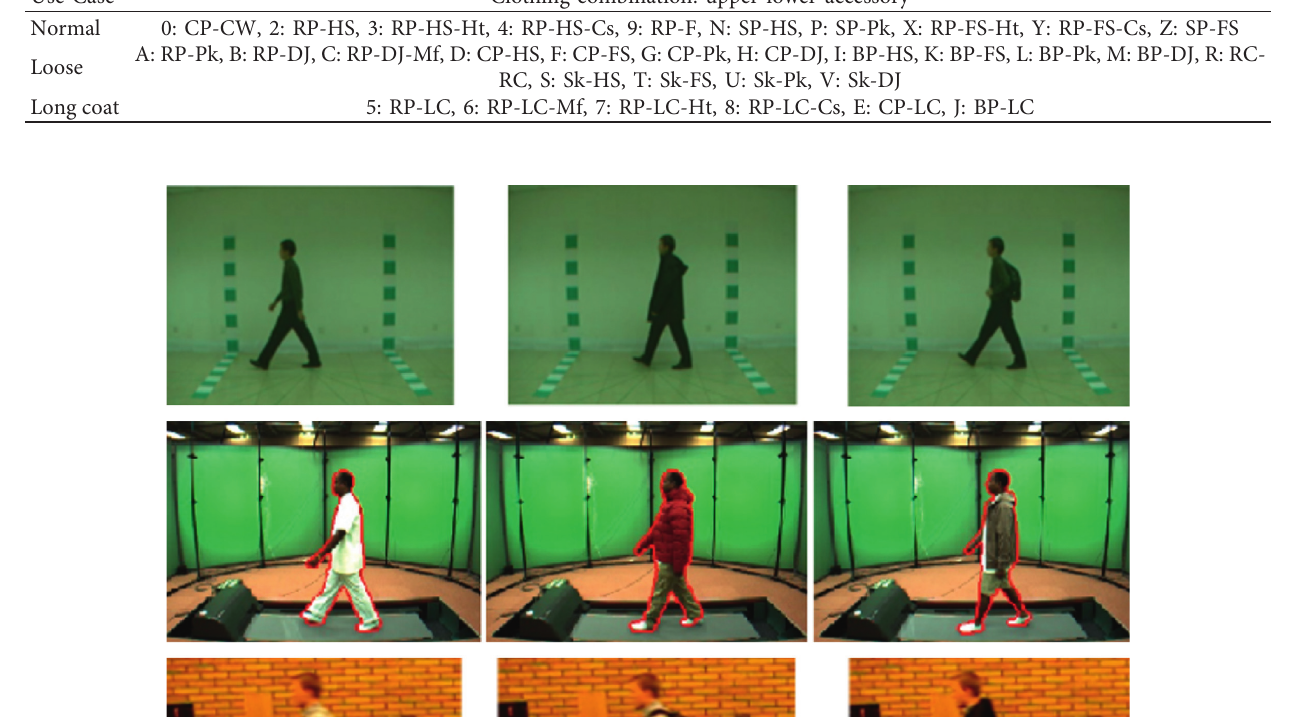
Table 2: Clothing types in OUISIR-B gait dataset categorized in Use Cases 1, 2, and 3 [28]. Use Case Clothing combination: upper-lower-accessory Normal